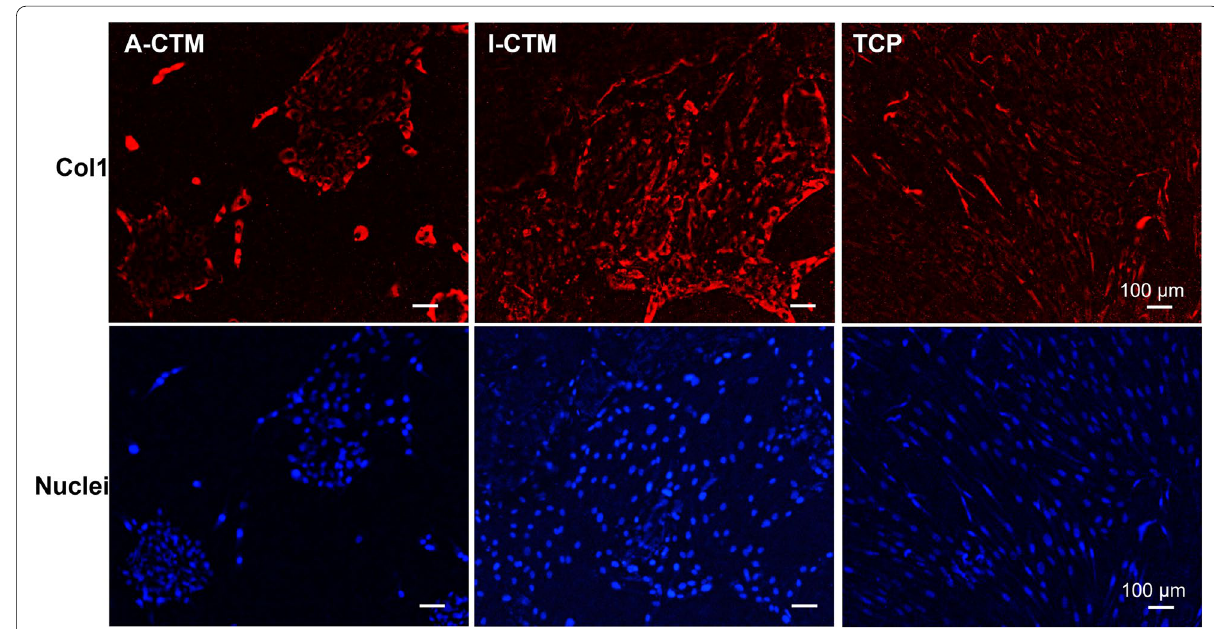
Fig. 6 Expression of type I collagen protein in tenocytes. Tenocytes on A-CTM, I-CTM or TCP were stained with anti-Col1 (red) and Hoechst dye (blue) after cultured for 7 days. Representative images were shown. Scale bar